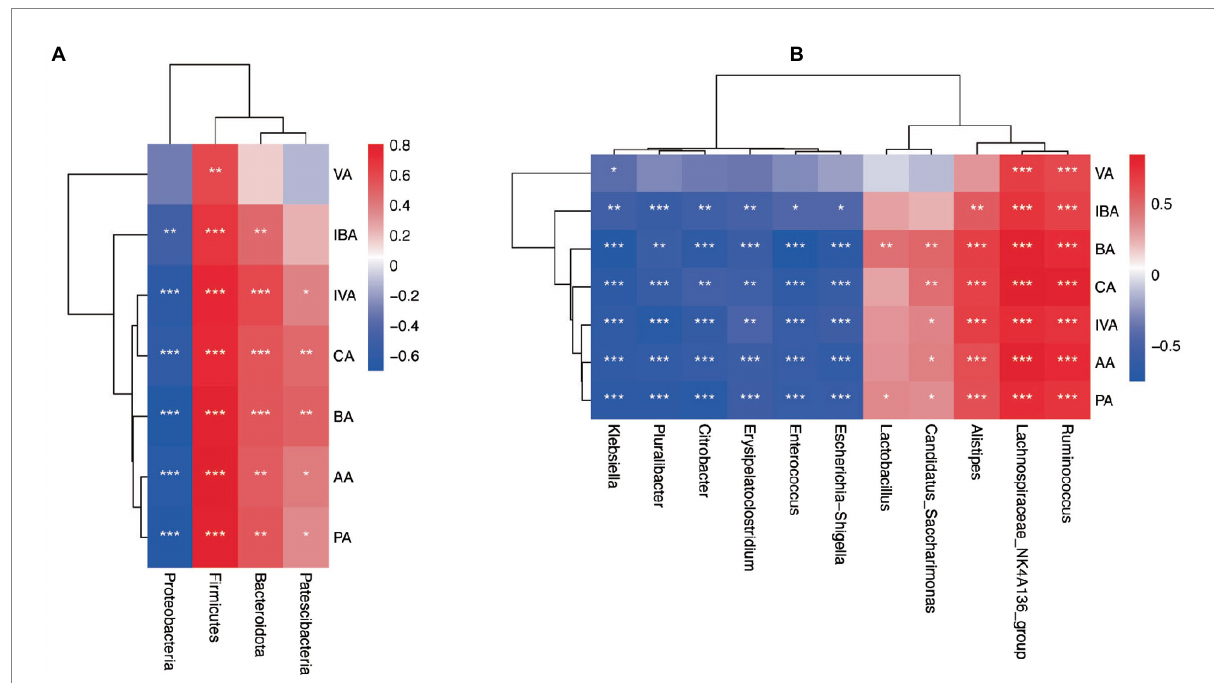
FIGURE 9 Correlation analysis heatmap. (A) Heat map of association between differential phyla and SCFAs. (B) Heat map of association between differential genera and SCFAs. acetic acid (AA), butyrate (BA), and propionic acid (PA), Isobutyric acid (IBA), isovaleric acid (IVA), valeric acid (VA), and caproic acid (CA). * p < 0.05, ** p < 0.01, *** p < 0.001.